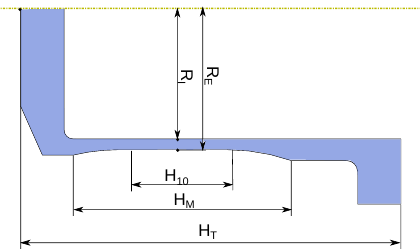
Figure 3. The schematic diagram of dynamic tensile test.